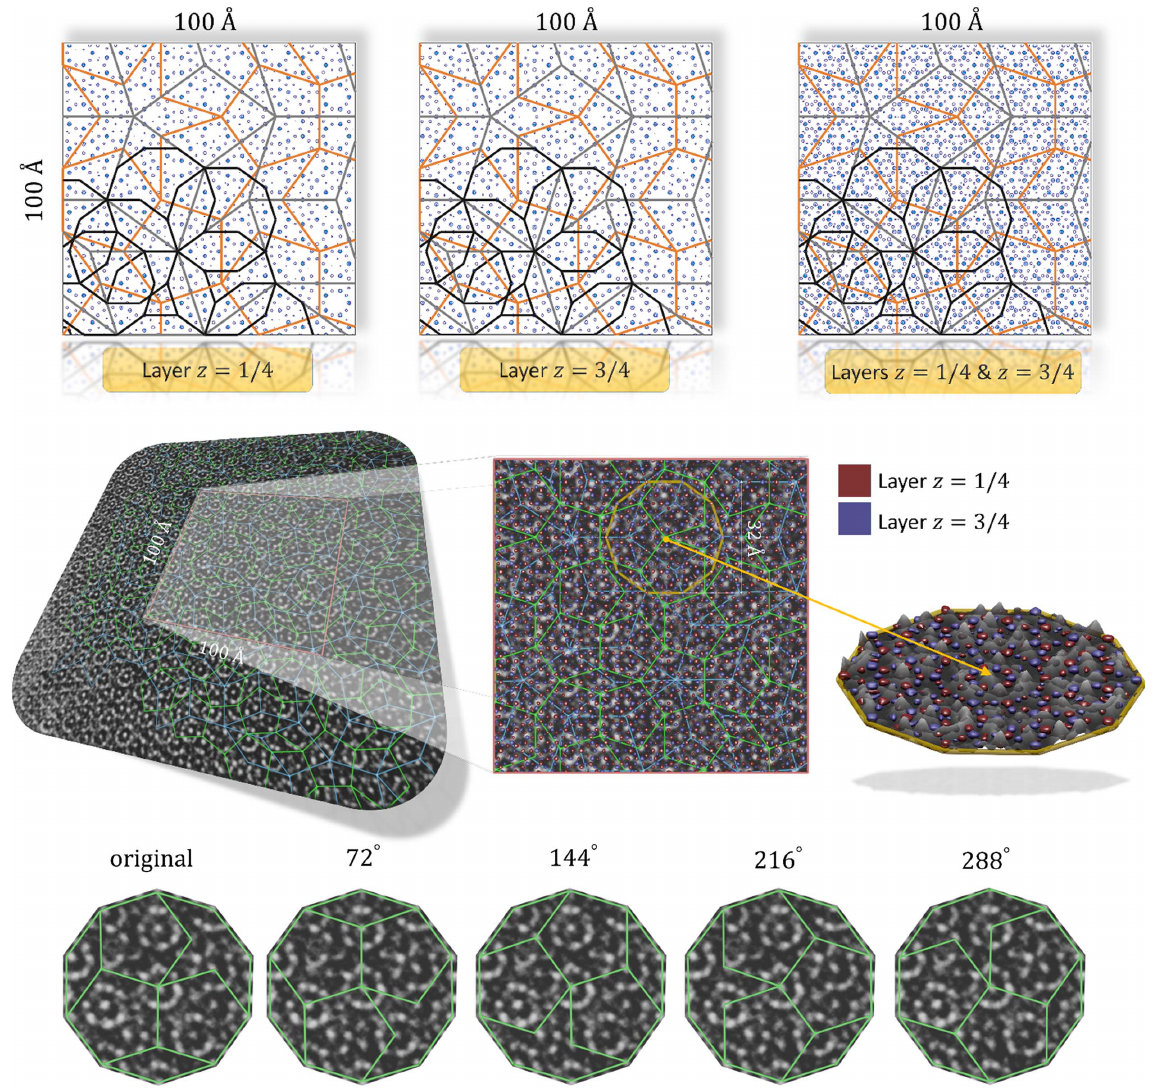
Figure 3 (Top) 2D section through the physical space electron density map perpendicular to the tenfold direction. The RPT (gray) and PPT (orange) are plotted over the contour plot. Hiraga clusters (black) are centered at the vertices of the PPT. (Bottom) HRTEM image of the decagonite structure with both RPTand PPT plotted over the image for guidance. Plotted tiling are (cid:9) times deflated in comparison with tilings in top contour plots. The isosurfaces of the electron density are compared with the magnified patch of the HRTEM image further supporting the agreement between the obtained ab initio structure solution and the real-space structure. The positions of clusters that are not centered in the PPTare located in the positions of the rearranged tiling: these are phason-flip-equivalent